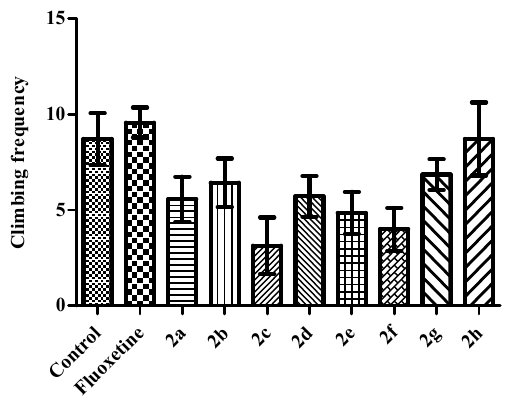
Figure 5. The effects of the test compounds ( 2a – 2h ) and fluoxetine on the climbing frequencies of the mice in MFST. Values are presented as mean ± SEM, ( n = 7).